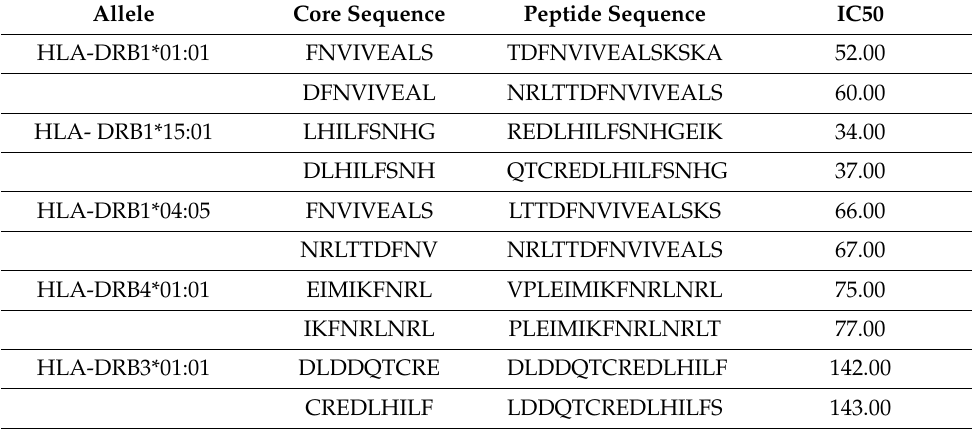
Table 11. Predicted peptides on risk alleles for human La.